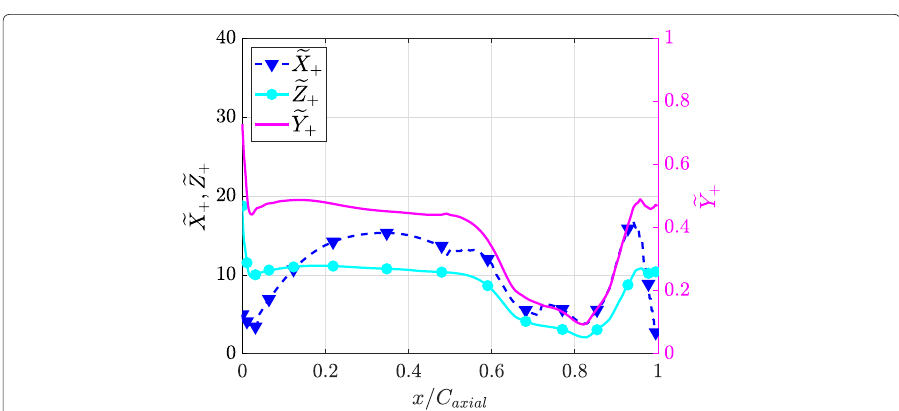
Fig. 4 Mesh normalized resolutions (based on wall units) on the suction side of the blade surface using p3 solution on the fine mesh ( DNS